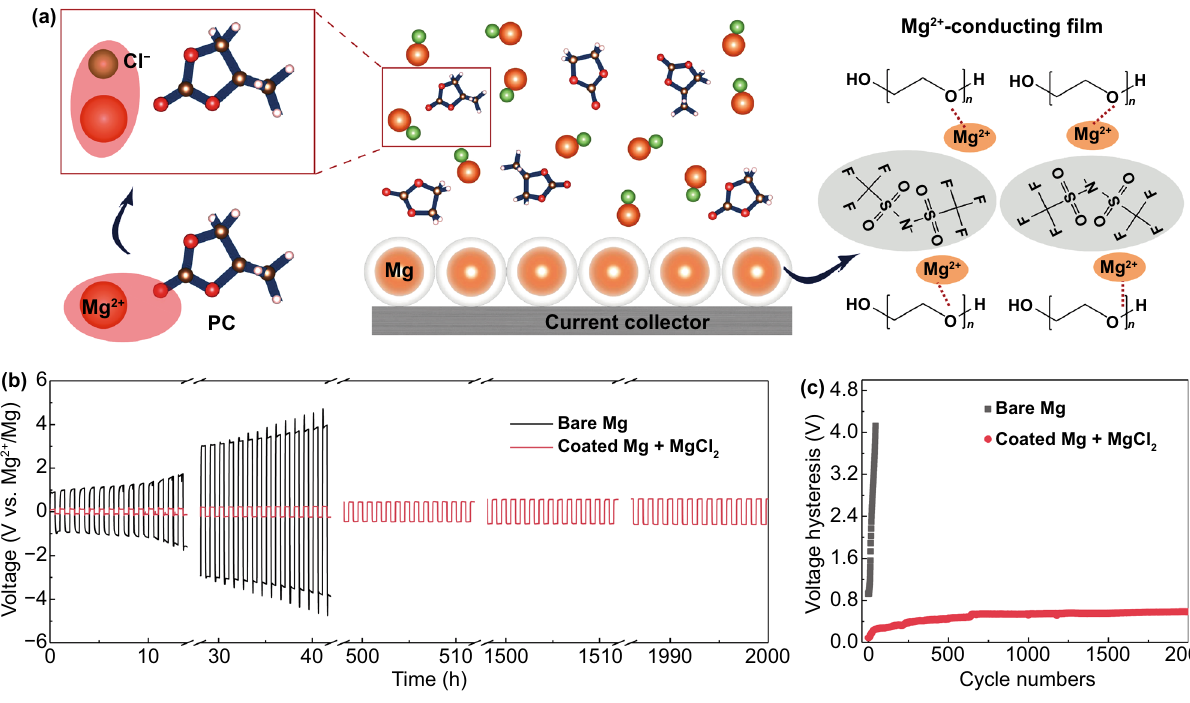
Fig. 1 a Schematic diagram of cooperative solvation/surface engineering. b Voltage responses of symmetric Mg batteries with and without col- laborative regulation in 0.5 M Mg(TFSI) 2 electrolyte systems at a current density of 0.01 mA cm −2 where each deposition/stripping cycle lasts for a half hour. The cell made with pristine Mg electrodes shows huge overpotential at the beginning and fails after 30 cycles, whereas the cell made with the cooperative engineering of solvation and interface performs prolonged cycles in carbonate-based electrolytes. The reversibility is conspicuous in the latter as proven by up to 2,000 cycles. c Voltage hysteresis versus cycle numbers for symmetric Mg electrodes. Lower voltage hysteresis is observed on modulated Mg electrode and